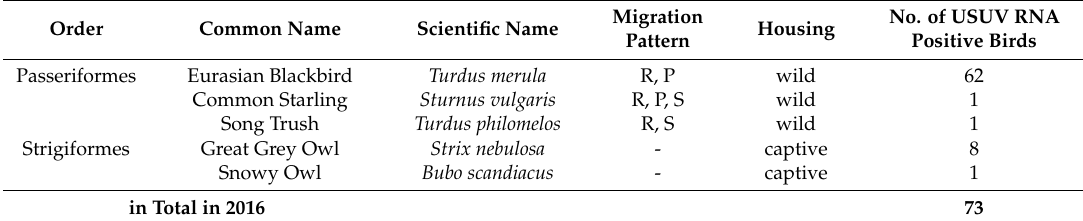
Table 3. Dead birds found positive for Usutu virus infection by qRT-PCR in